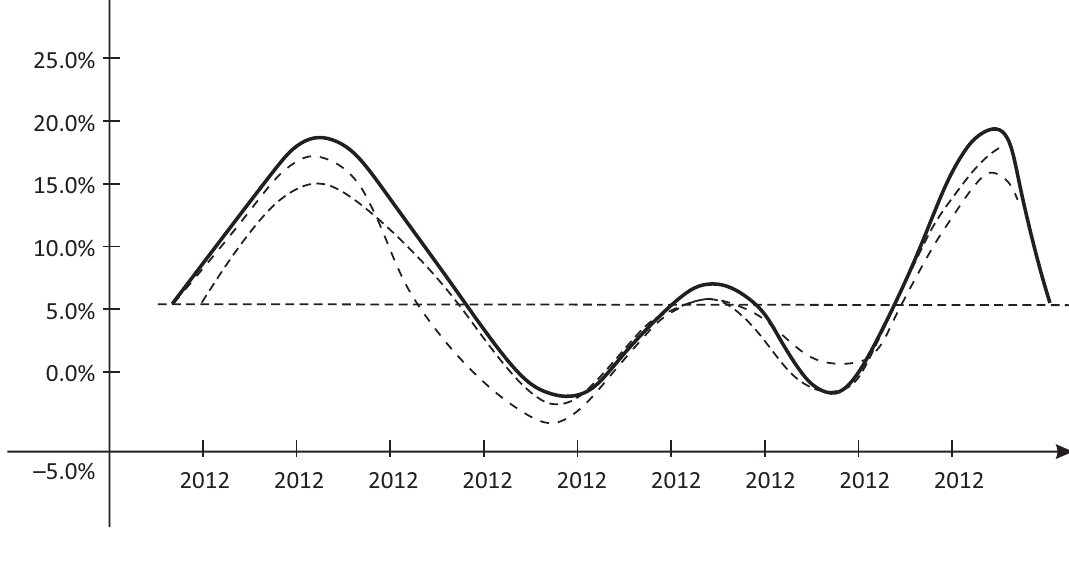
Figure 2. Capital expenditures of ports during the crisis